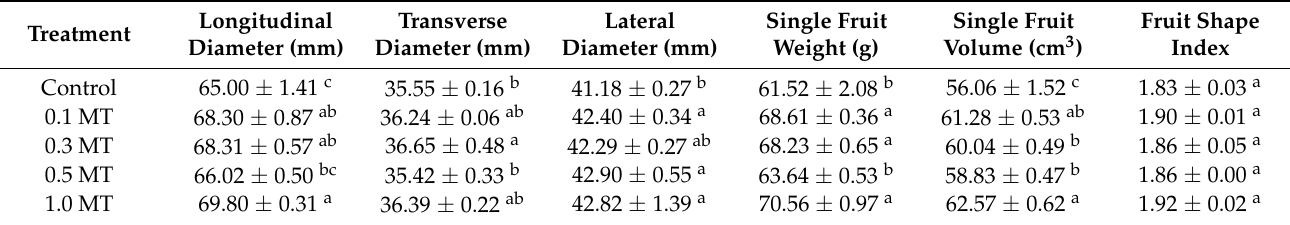
Table 3. Effect of MT on the development of